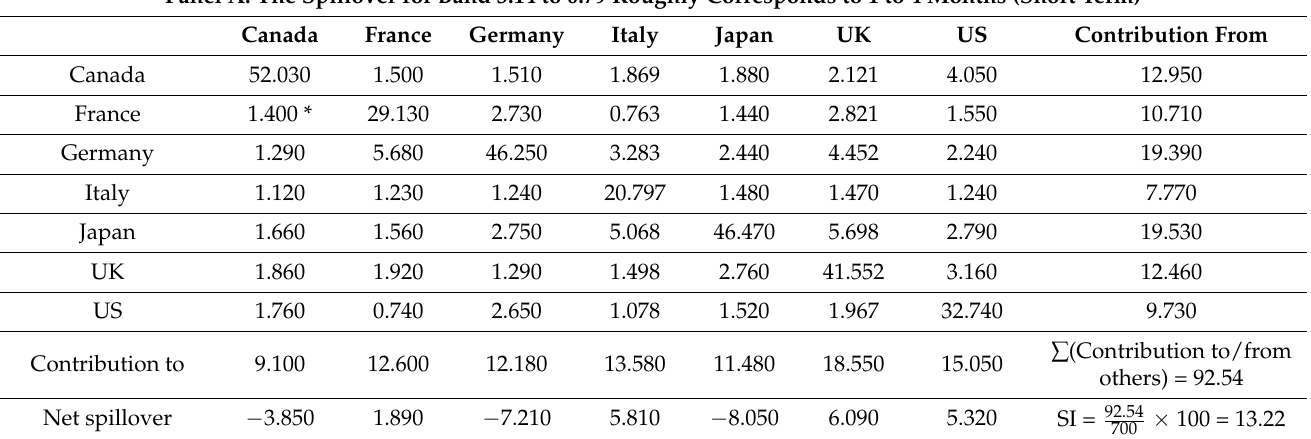
Table 4. Frequency-domain inflation spillover based on the Barunik and Krehlik (2018)